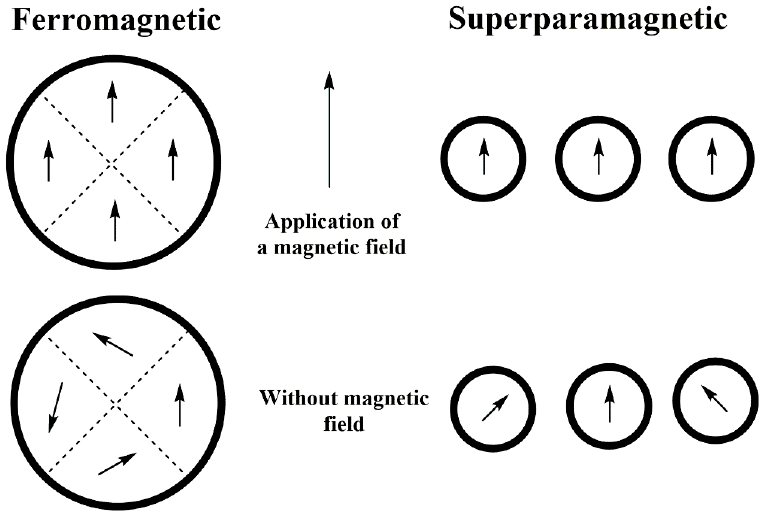
Figure 2. Effect of exposure to a magnetic field of ferromagnetic and superparamagnetic